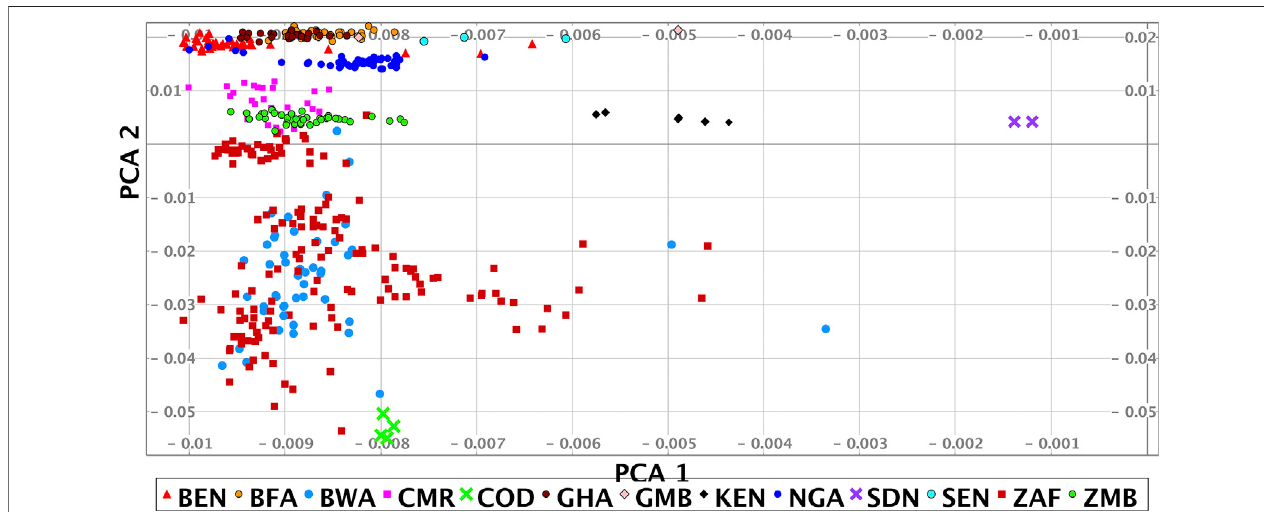
FIGURE 2 | Principal component analysis of the HAAD (some outliers are omitted). Abbreviations for sources used are H3A (Human Health and Heredity in Africa Consortium), and SF (Simons Foundation Genome Diversity Project). The countries of origin and source of the samples shown in the PCA are: BEN/H3A, BFA/H3A, BWA/H3A + SF, CMR/H3A, COD/SF, GHA/H3A, GMB/SF, KEN/SF, NGA/H3A + SF, SDN/SF, SEN/SF, ZAF/H3A + Tiemessen Lab + SF + Southern African Human Genome Program, ZMB/H3A. Country codes given in Figure 1 .